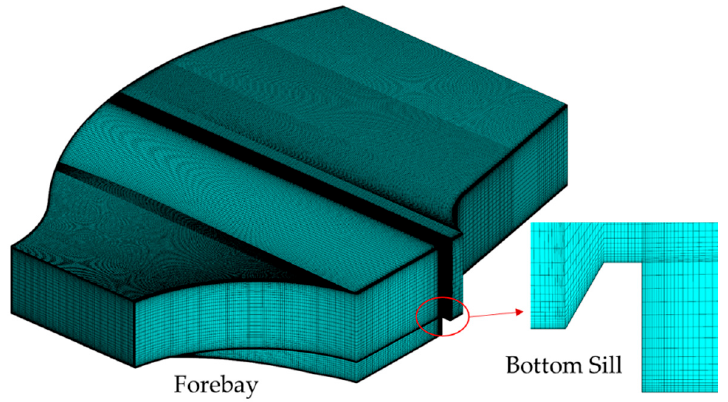
Figure 3. The g rid of the forebay. Figure 3. The grid of the